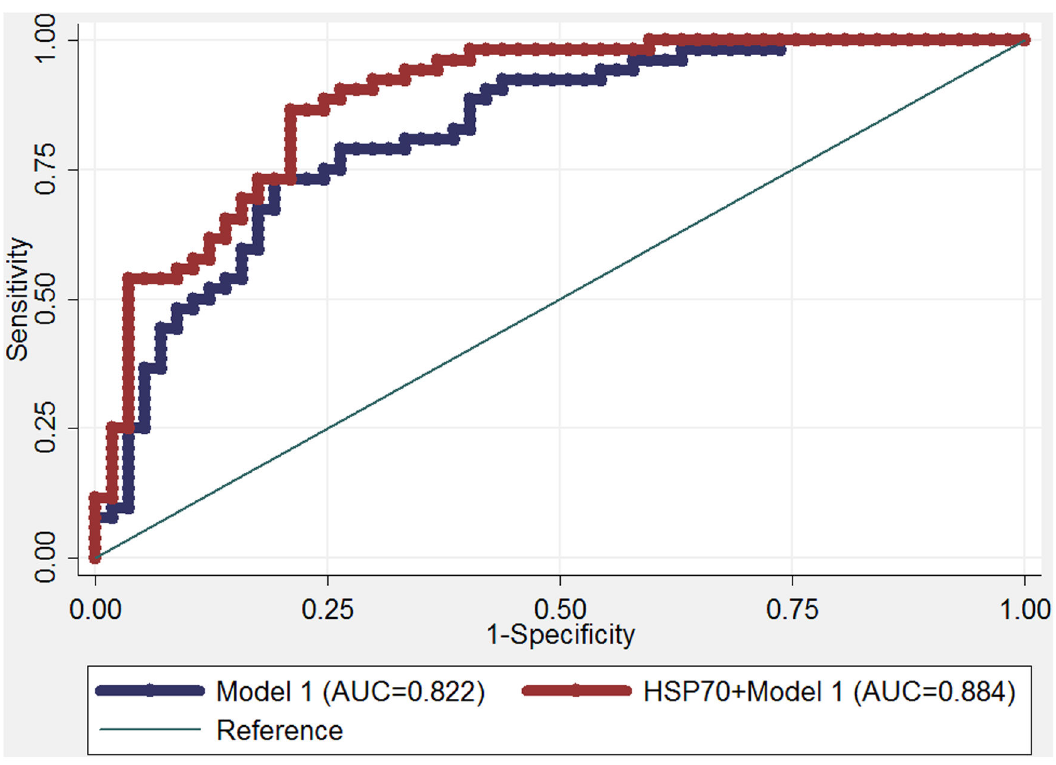
Figure 3. ROC curves and corresponding AUCs for PCOS using models without or with serum Hsp70 level. The AUC in model 1 was 0.822 (95% CI 0.744-0.900), and that in a model with serum Hsp70 level plus the model 1 was 0.884 (95% CI 0.822-0.946); P = 0.015 for the difference of the AUCs. The established conventional model here consists of age, BMI, GI, HOMA- IR, CHO and TG. doi: